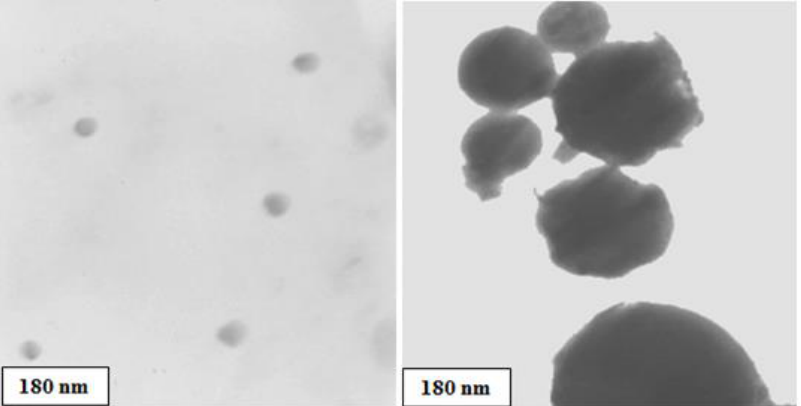
Figure 8. TEM micrographs of ferrosilicomanganese fines. Two types of aggregates of different sizes are shown.